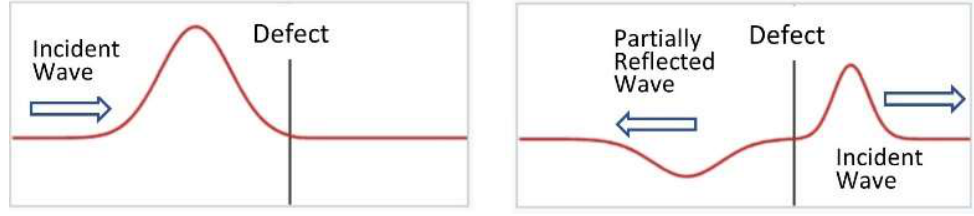
Figure 1. Time domain reflectometry (TDR) (Revised plot based on Oleg [13]).